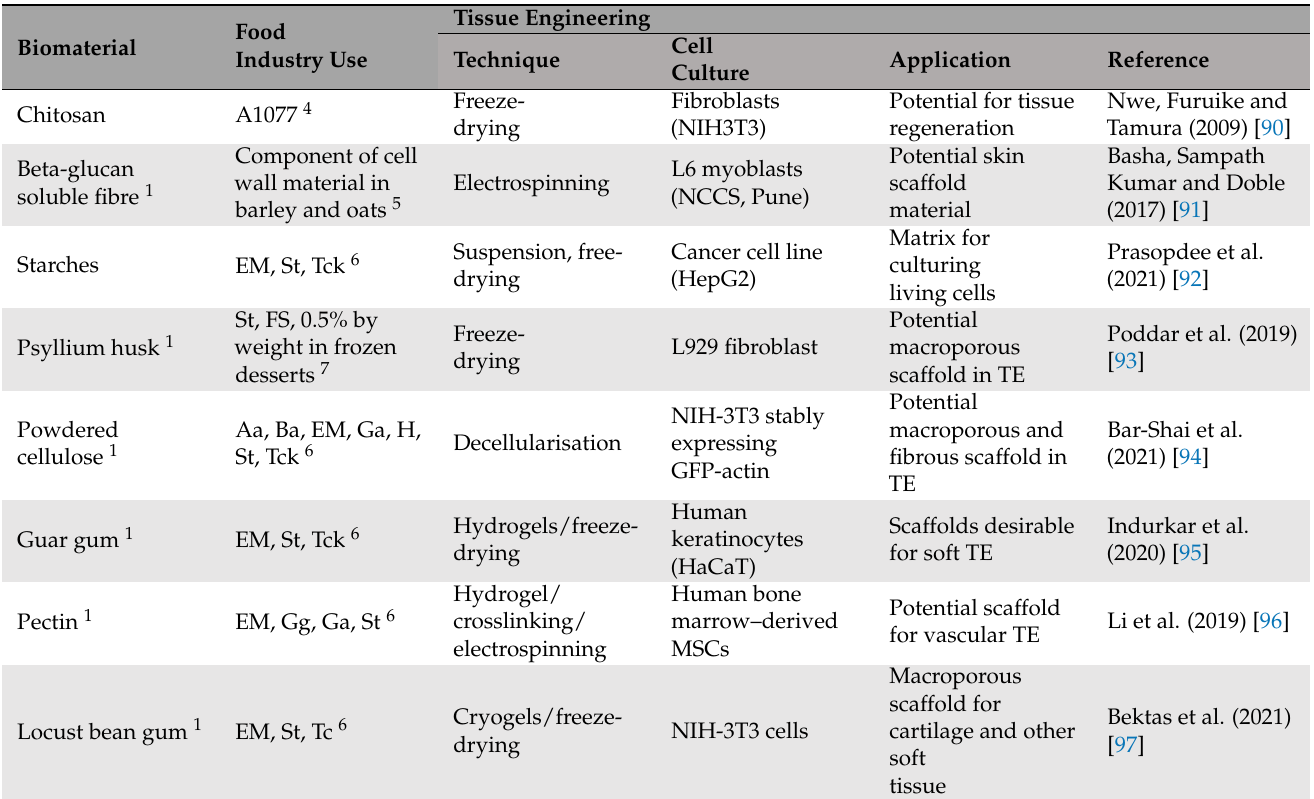
Table 4. Examples of substances recognised by the Food and Drug Administration (FDA) as safe for food industry use that have been used to construct